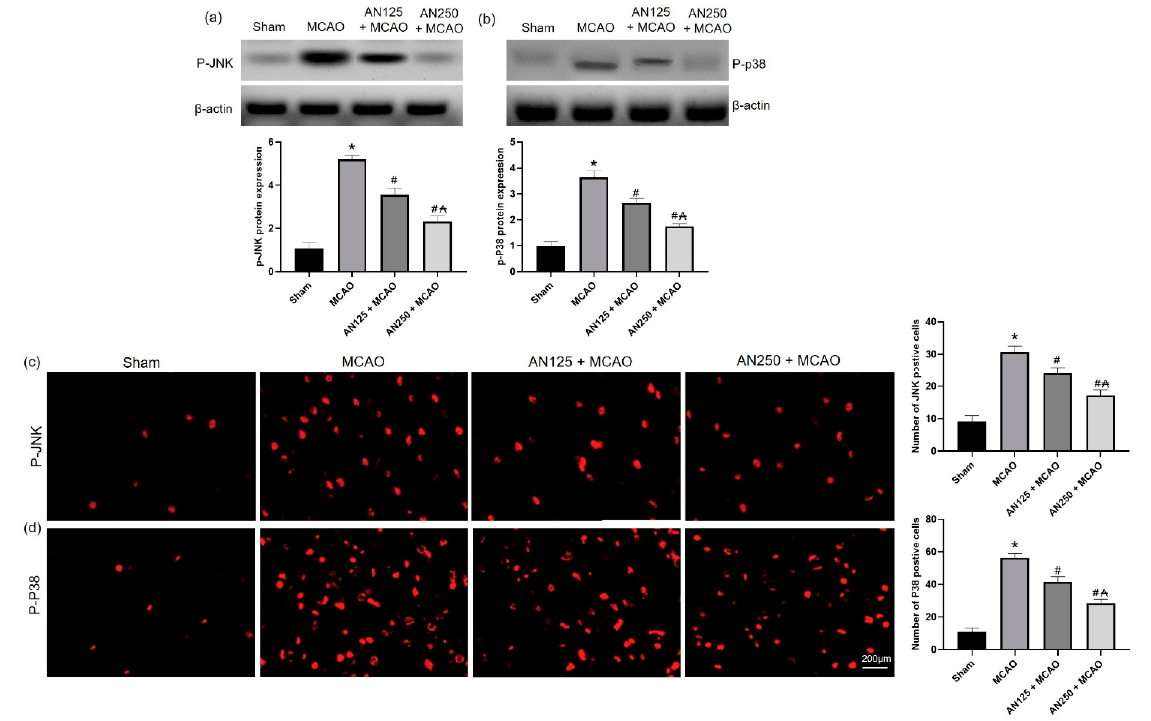
Figure 4. The impact of pretreatment with anethole (AN, 125, 250 mg/kg, orally) for two weeks in MCAO-induced cerebral ischemia/reperfusion in rats on the protein expression of ( a ) p-JNK and ( b ) p-P38 and on the immunofluorescence staining of ( c ) JNK and ( d ) p38 (×400). Data are expressed as mean ± SD ( n = 6). * significantly different from the sham-operated group, # significantly different from the MCAO ischemic group, and ₳ significantly different from the AN125 + MCAO group at p < 0.05 using ANOVA followed by Tukey’s post hoc test.